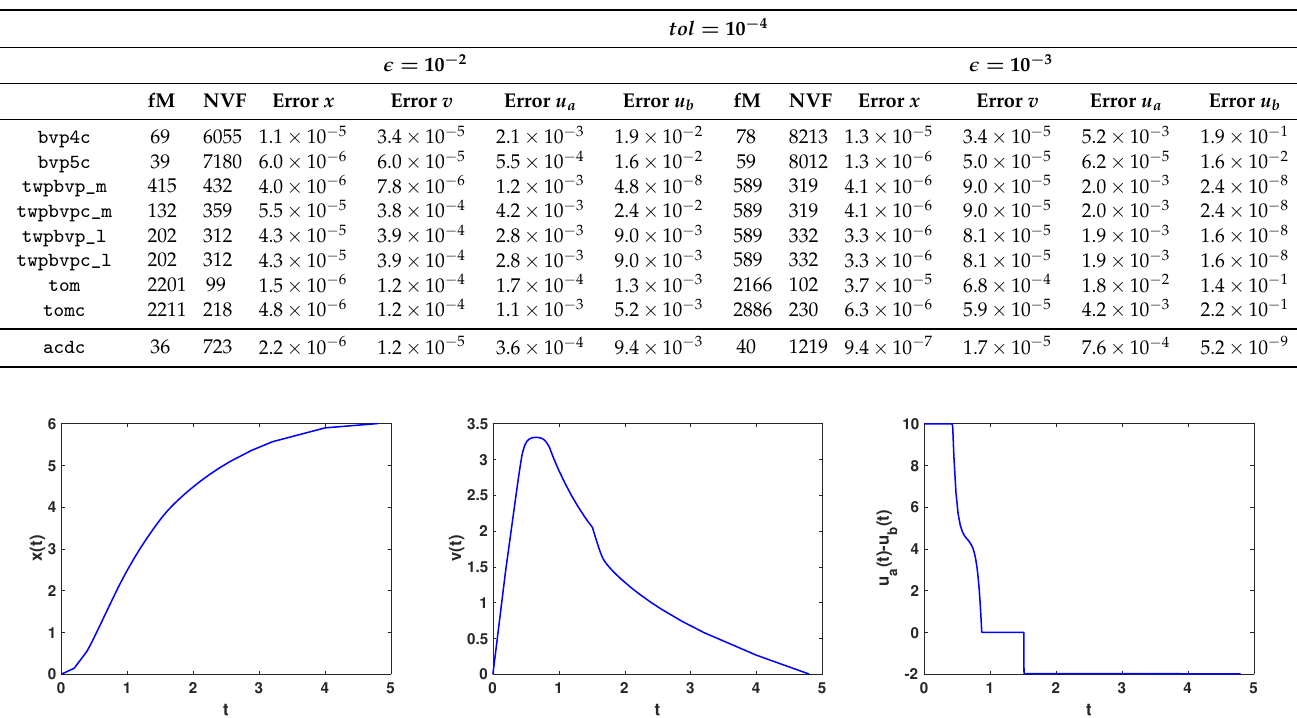
Table 22. Minimization of the fuel cost in the operation of a train (18) using a piecewise quadratic penalty function with τ = 10 − 2 and continuation strategy: final mesh (fM), total number of vectorized function evaluation (NVF) and mixed errors for x , v , u a , u b .